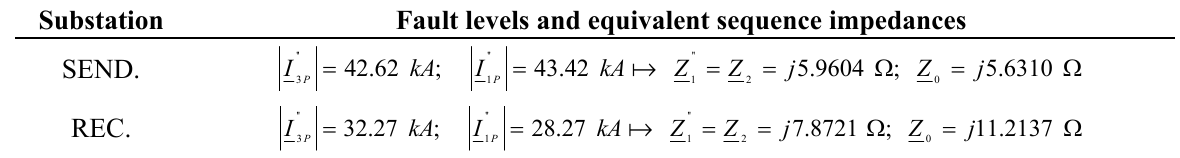
Table 4. Data assumed in the MCA for fault levels.